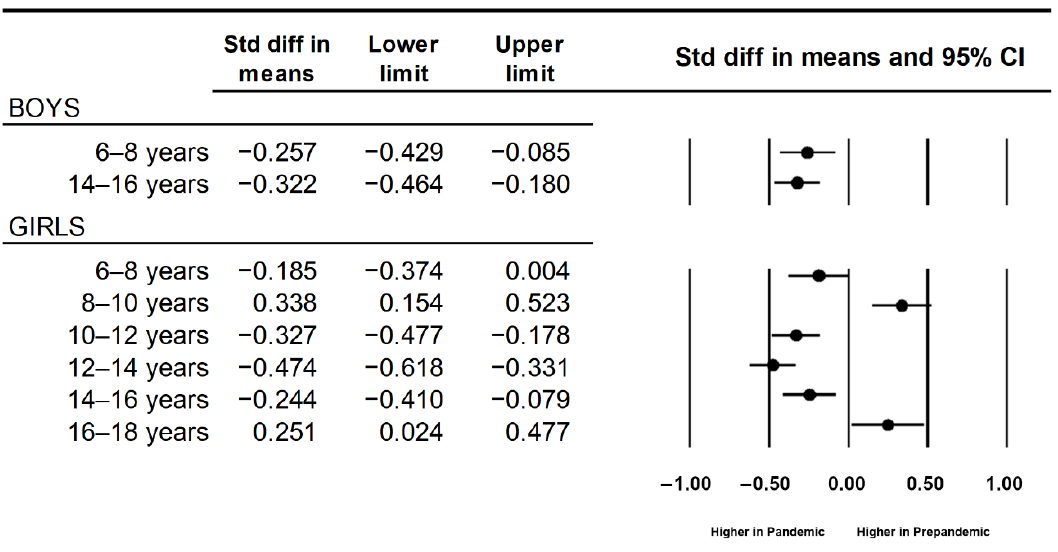
Figure 4. Standardized mean differences (Cohen’s d) between prepandemic and pandemic samples